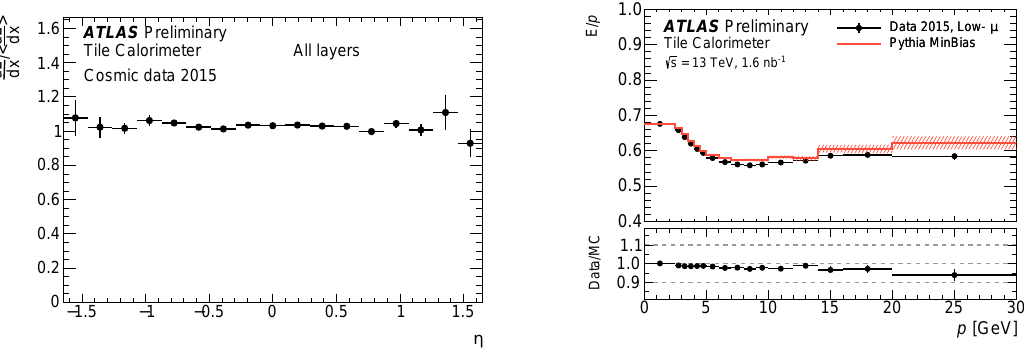
Figure 3: Ratios of the truncated means of the distributions of the energy deposited in the layer cells by cosmic-ray muons per unit of path length, dE / d x , obtained using 2015 data as a function of the pseudorapidity, η (Left) [ 6 ] . The calorimeter response to single isolated charged hadrons, characterised by the mean of the energy over momentum < E / p > as a function of momentum, integrated over the pseudo-rapidity and φ coverage of the calorimeter as measured by the ATLAS Tile Calorimeter using 1.6 fb − 1 of proton-proton collision data at 13TeV collected in 2015 (Right) [ 6 ] . cell are used to estimate the muon energy loss per unit distance, (cid:52) E / (cid:52) x . The stability or uniformity is expressed as the normalized truncated mean of dE / d x . The normalized mean of dE / d x is the ratio of dE / d x to the average dE / d x for all the cells. The uniformity of response is presented as a function of pseudorapidity, η , in Figure 3 (Left). We observe that the cell response non-uniformity in pseudorapidity is better than